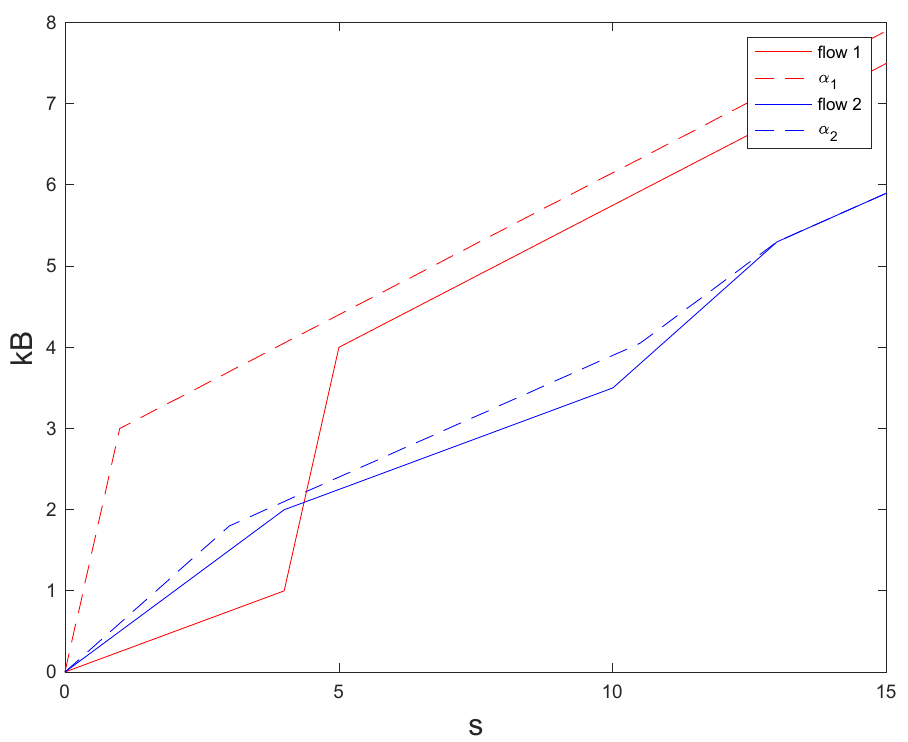
, α ) for them. Flow (cid:2869) (cid:2870)